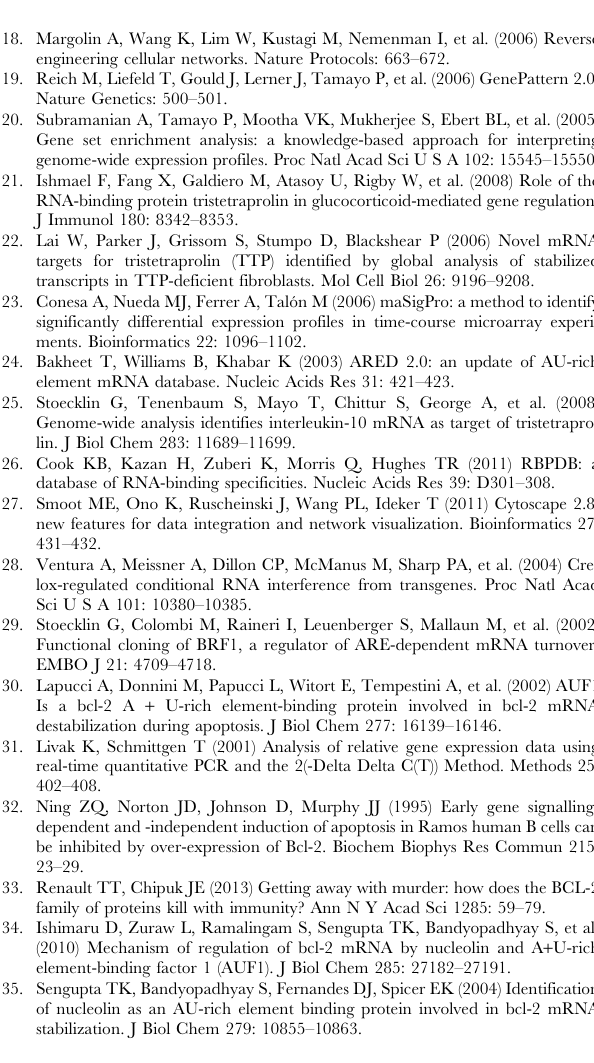
Figure S1 Production of bacterially expressed ZFP36L1 protein. Western blot showing recombinant human ZFP36L1 protein expression Lanes 1, 2 and 3 ( Ve + ): Positive controls containing 5, 1 and 0.2 m l of total protein lysate from BL21 E.coli cells, transformed with a recombinant pET15b vector containing the human ZFP36L1 open reading frame. Lane 4 ( Ve –): Negative control containing 5 m l of lysates from E.coli BL21 cells, transformed with an empty pET15b vector. Lanes 5, 6 and 7: correspond to 5, 10 and 20 m l of ZFP36L1 protein (approximately 100 ng/ m l) purified according to the protocol detailed in Materials and Methods. Anti-ZFP36L1 antibody (Cell Signaling Technology rabbit-anti-human ZFP36L1/L2 antibody) was used to detect ZFP36L1 protein. Figure S2 IL-3 mRNA levels are increased in BCL1 cells transduced with a ZFP36L1 ShRNA. IL-3 mRNA levels were measured by qRT-PCR in lentiviral mediated ZFP36L1 ShRNA transduced BCL1 cells (see Fig. 4A) and cells transduced with